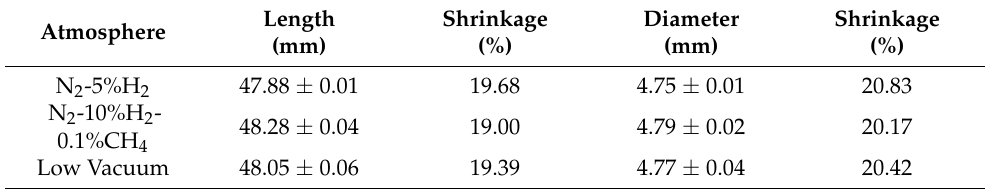
Table 7. Dimensional analysis of sintered parts with optimum densifications (sintered at 1325 °C for 12 h).